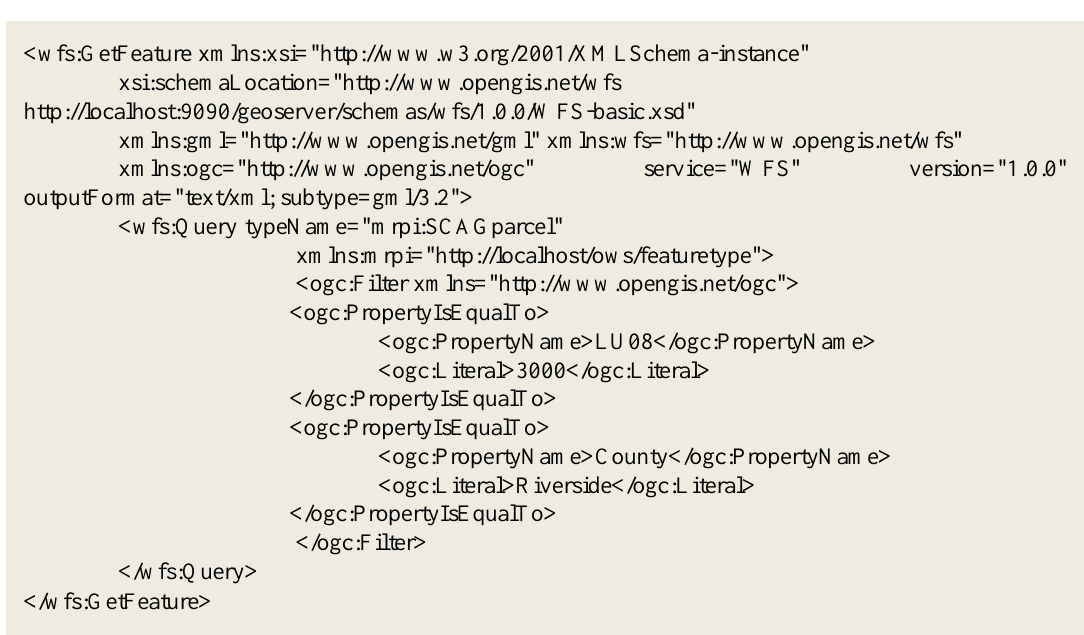
Figure 3. A sample Web Feature Service (WFS) ―GetFeature‖ request to subset